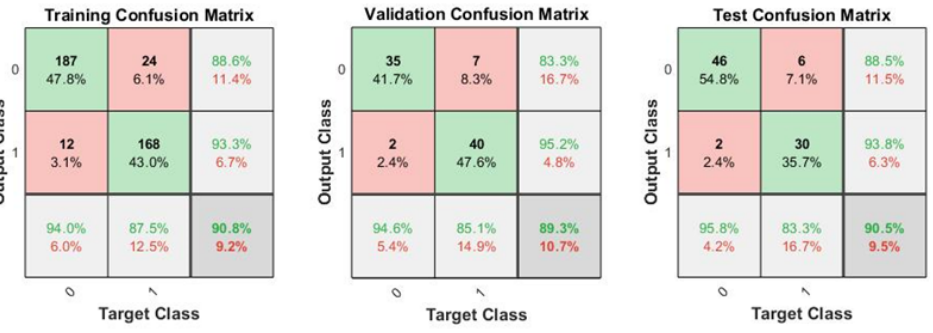
Figure 20. Detection ANN performances. Results are provided for the training, validation, and test subsets.